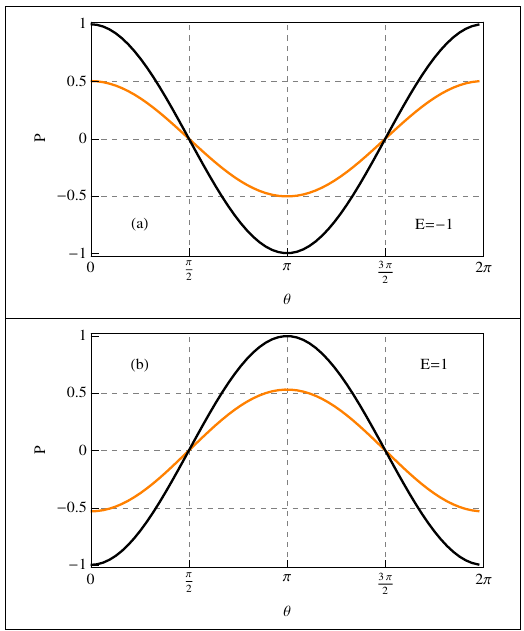
Figure 4. P as a function of θ ( θ i = θ ∀ i ) at two different energies, where the orange and black lines correspond to A x = 0.5 and 1, respectively. The AAH phase φ ν = 0.